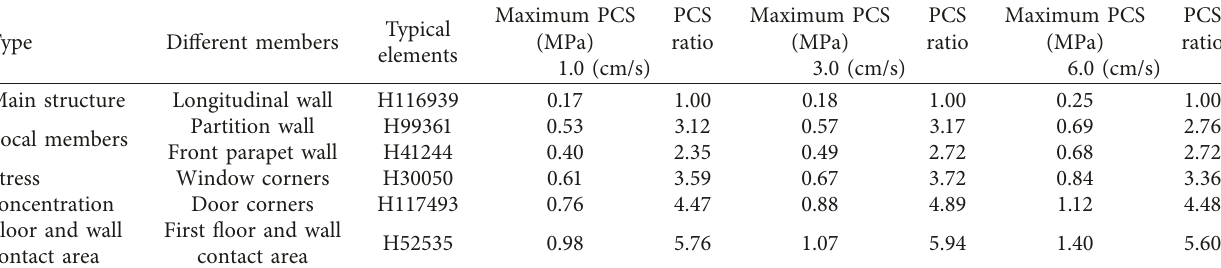
Figure 25. The PTS ratio curve of local members under different peak particle velocities is shown in Figure 26.